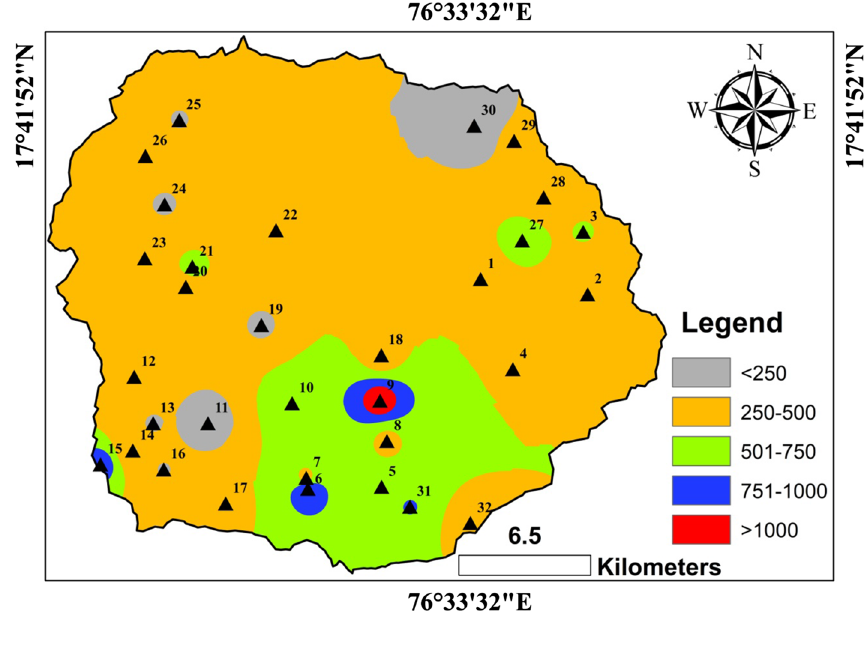
Fig. 5 Geospatial distribution of EC